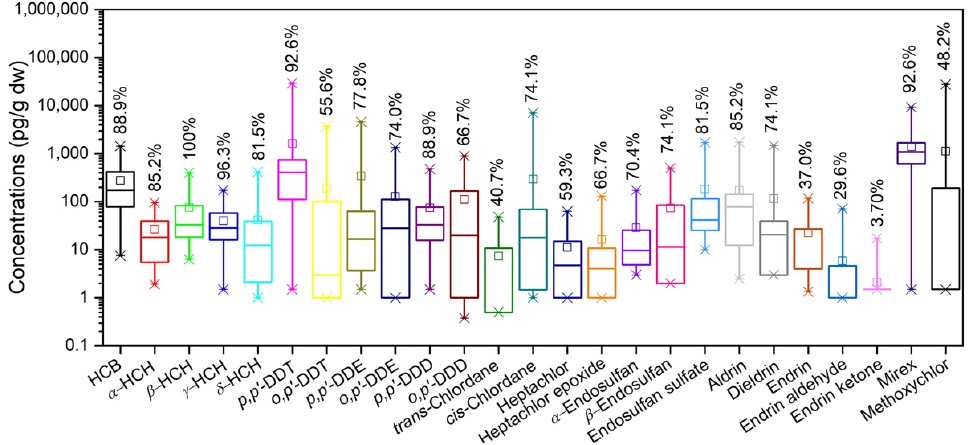
Figure 2. Concentrations and detection rates of individual OCPs in the study karst